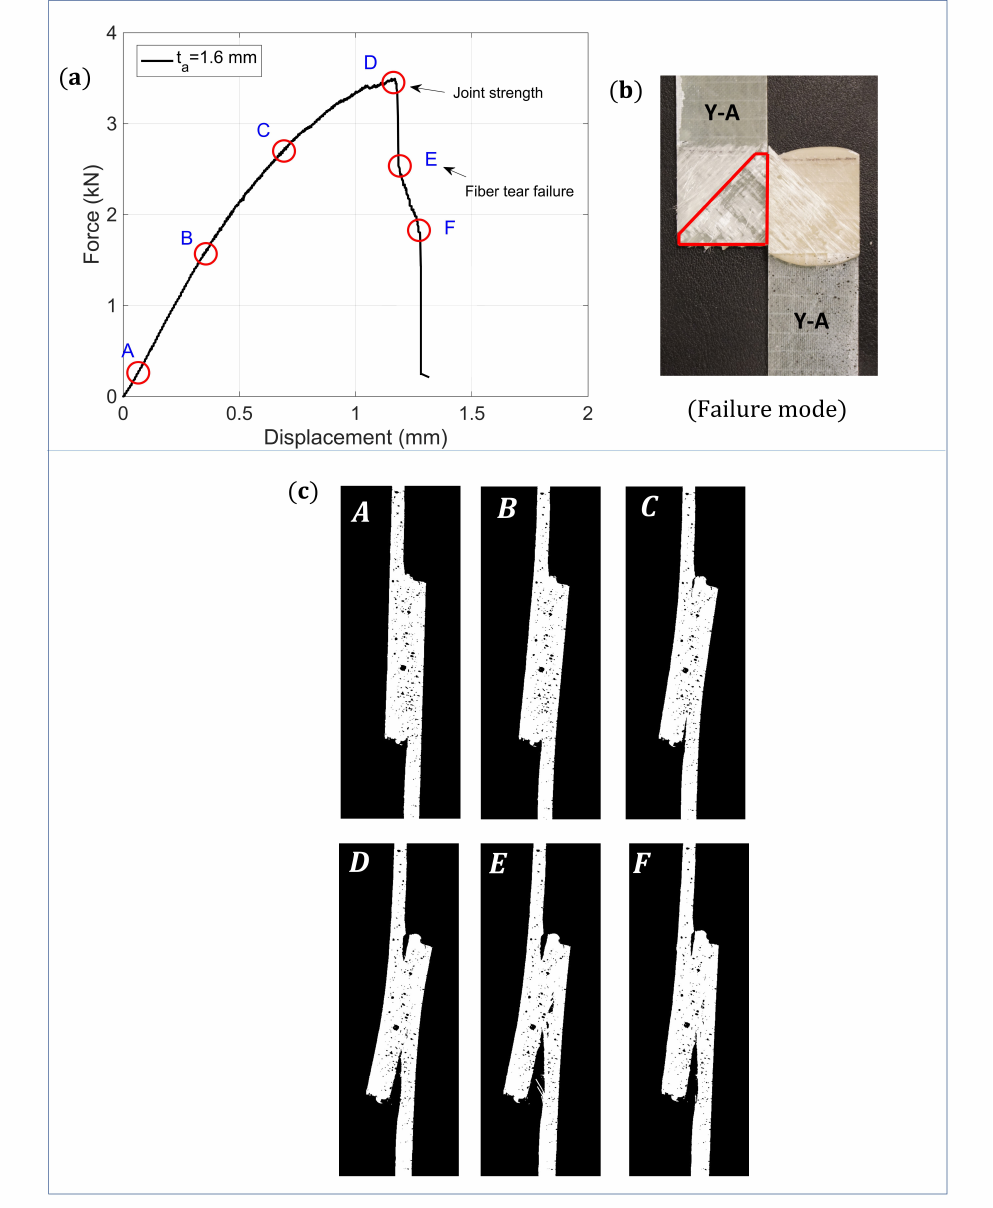
Figure 12. Tensile lap shear test results for intact joints: ( a ) Force-displacement history, ( b ) dominant failure mode, and ( c ) state of joint at different points A-H along the force-displacement